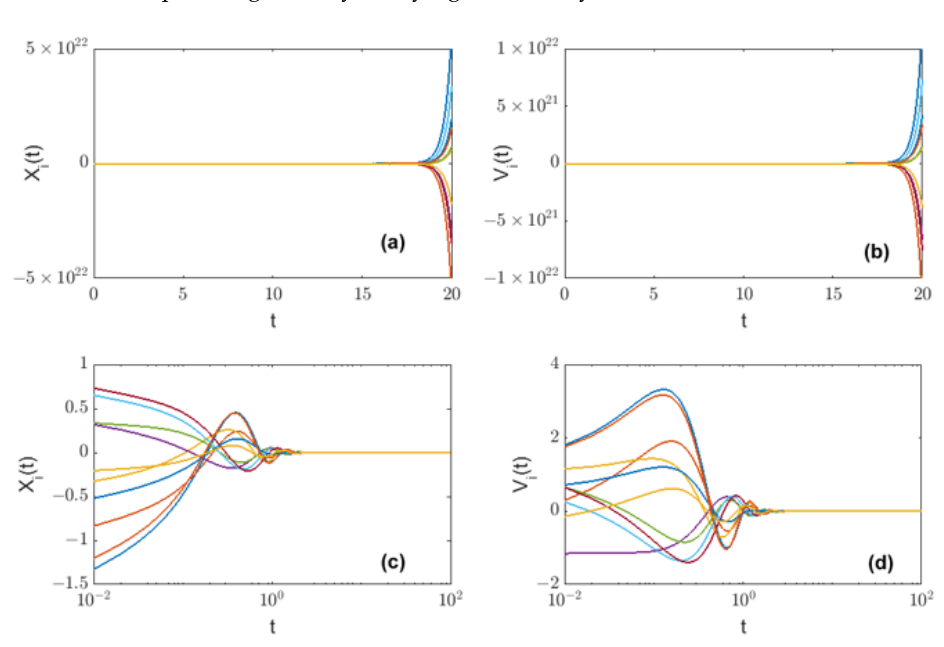
Figure 4. The curves of the position ( a , c )/velocity ( b , d ) of each agent as a function of time of FOMAS (3) with different orders p when a = 1 ( a , b ) and a = 20 ( c , d ) (the case d ≥ 0, c < 0). When the position coupling strength c = 0.1, the velocity coupling strength d = −